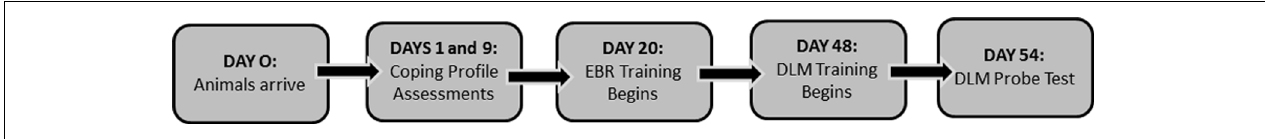
FIGURE 1 | Timeline for behavioral procedures utilized in the current study. Animals arrived in the laboratory at approximately 23 days of age then were exposed to the sequence of events in this